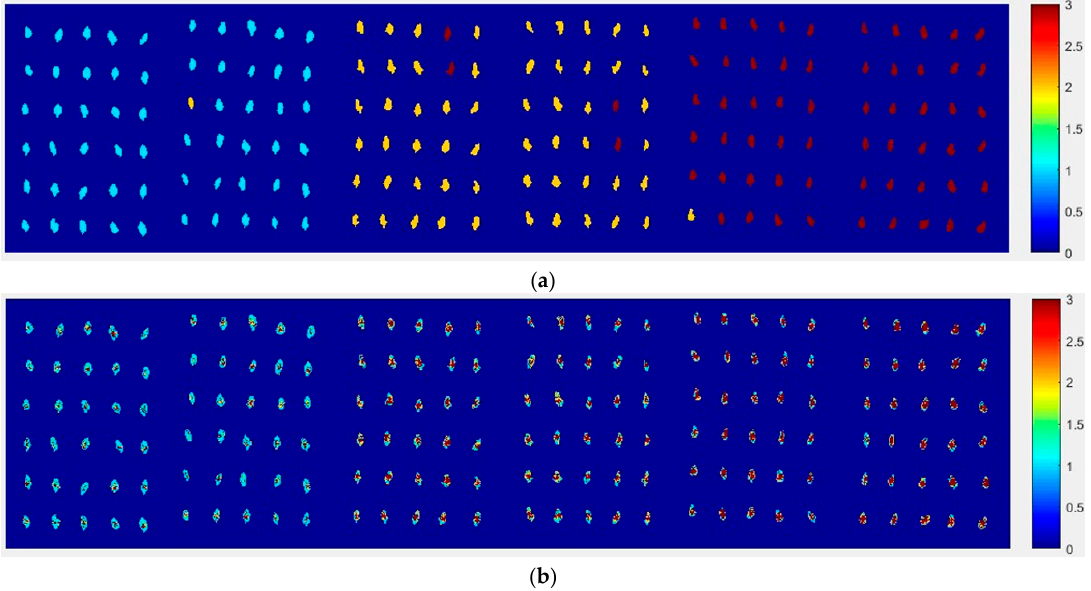
Figure 10. The visualization images ( a ) method M2M and ( b ) method M2P for Haihe78 with the SPA and PLS-DA model.